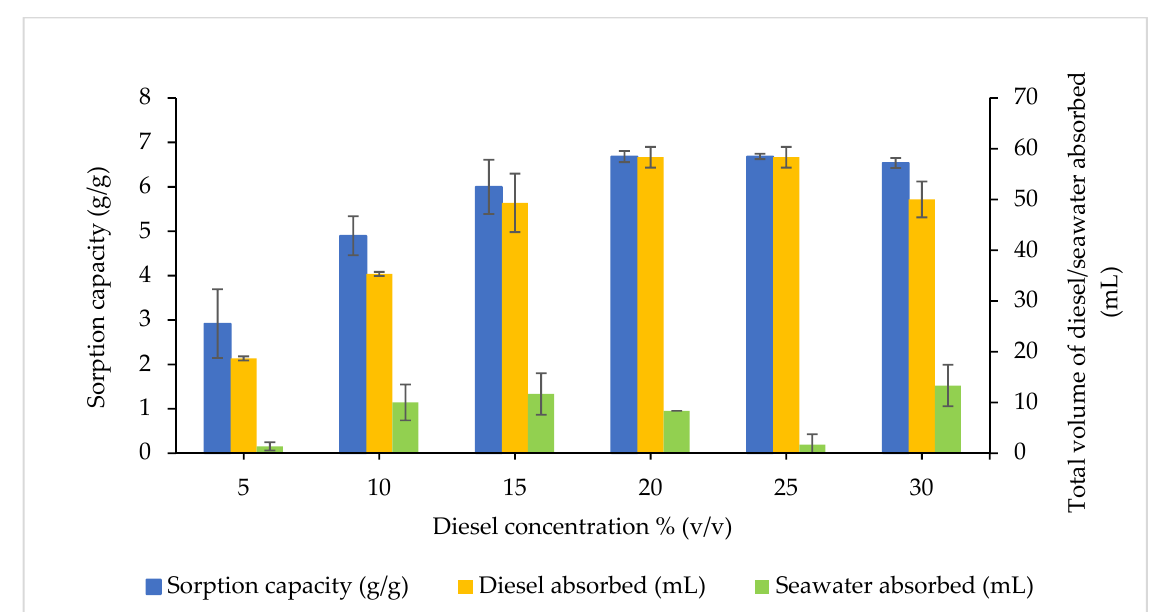
Figure 8. Effects of diesel concentrations based on their sorption capacity (g/g) and the diesel–seawater absorbed (g/mL). The error bars represent the mean ± SEM for three replicates ( n = 3). Packing density constant at 0.06 g/cm 3 .